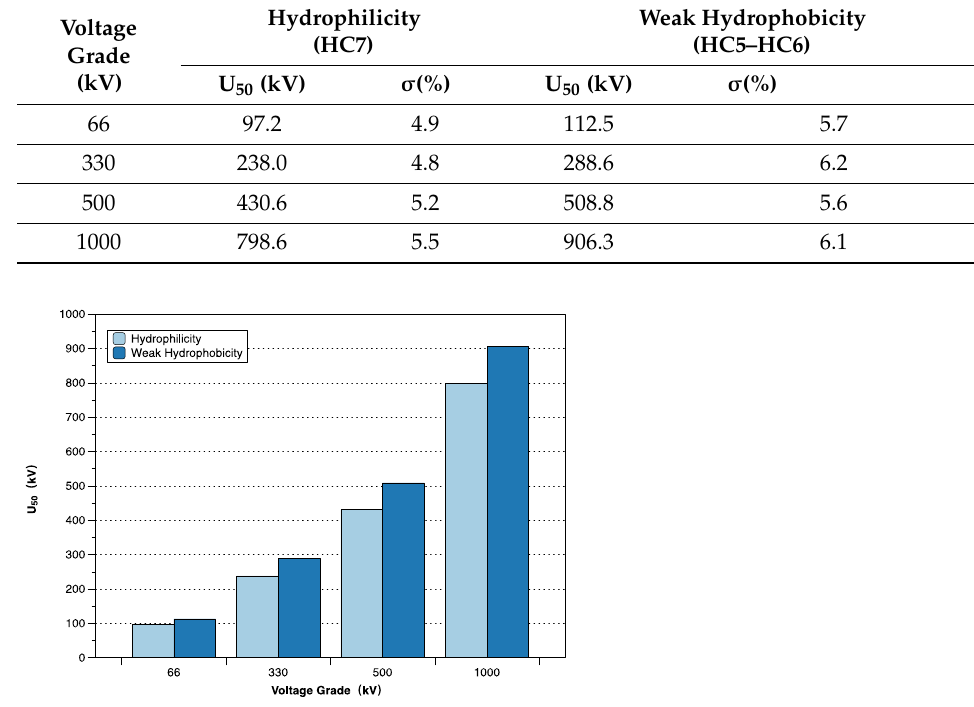
Figure 5. Comparison of pollution flashover test results of composite crossarm insulators with different hydrophobic states.